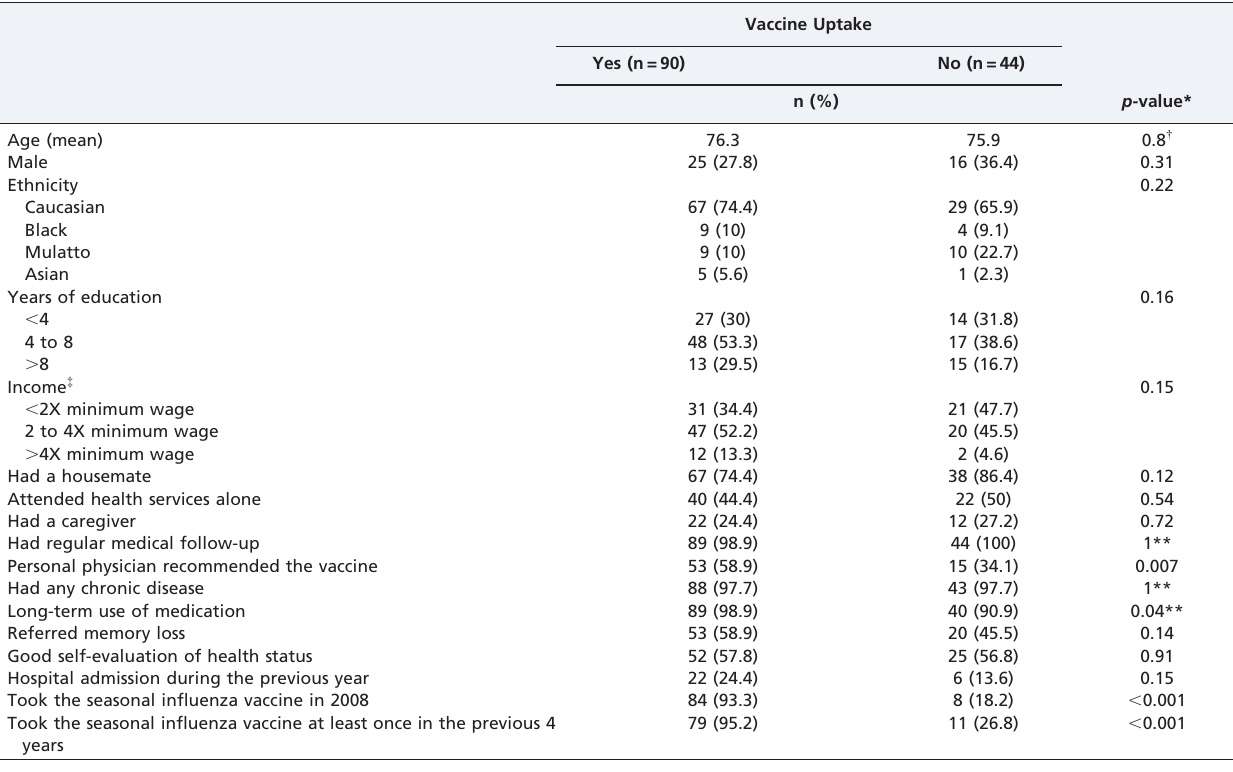
Table 1 - Characteristics of the interviewed patients according to their seasonal influenza vaccine uptake in 2009.